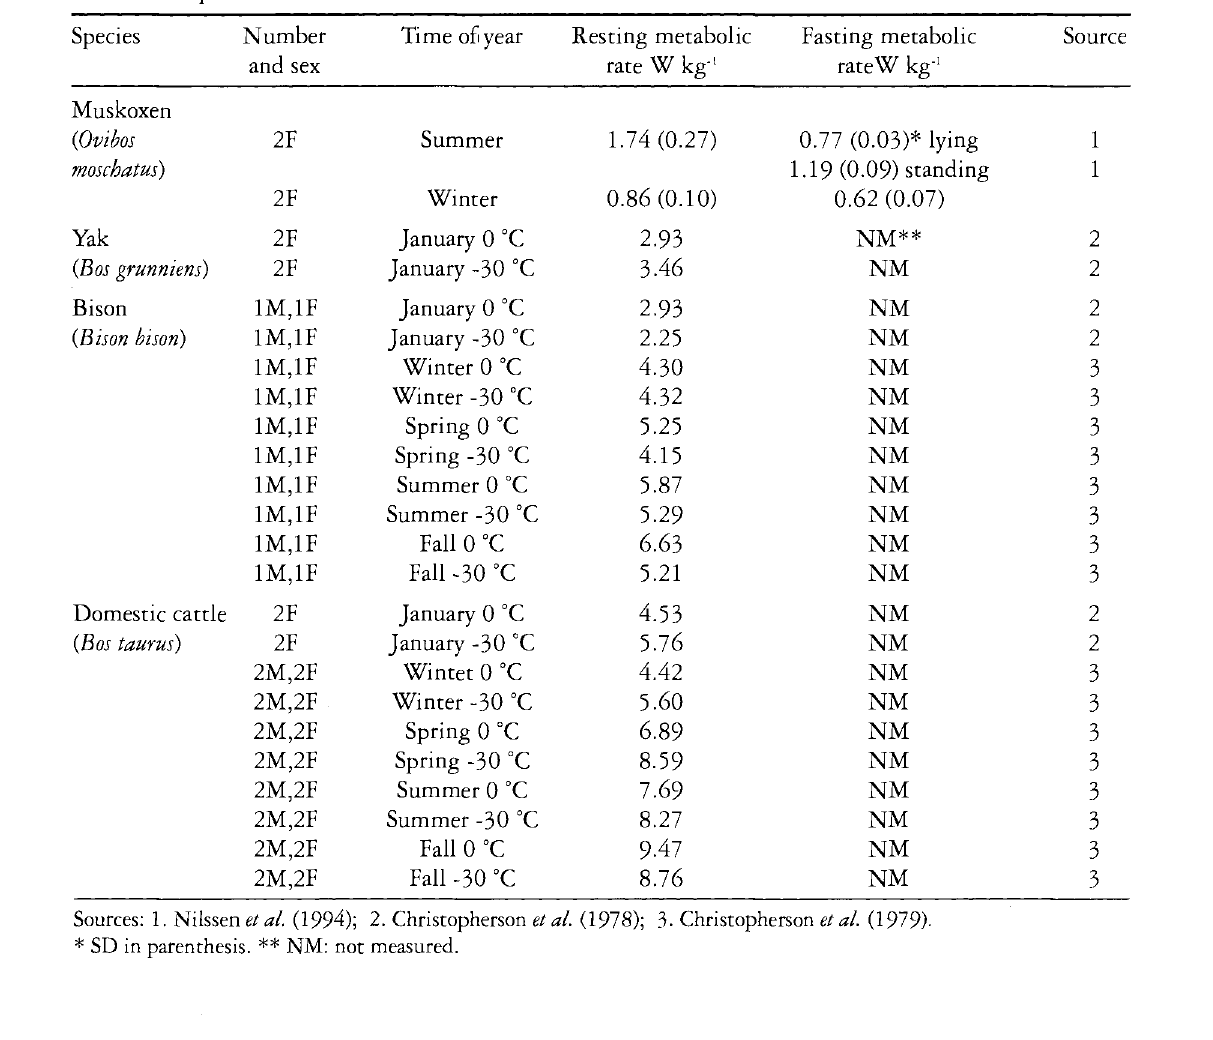
Table 6. Comparison of metabolic rates in Bovidae. Species Resting metabolic Fasting